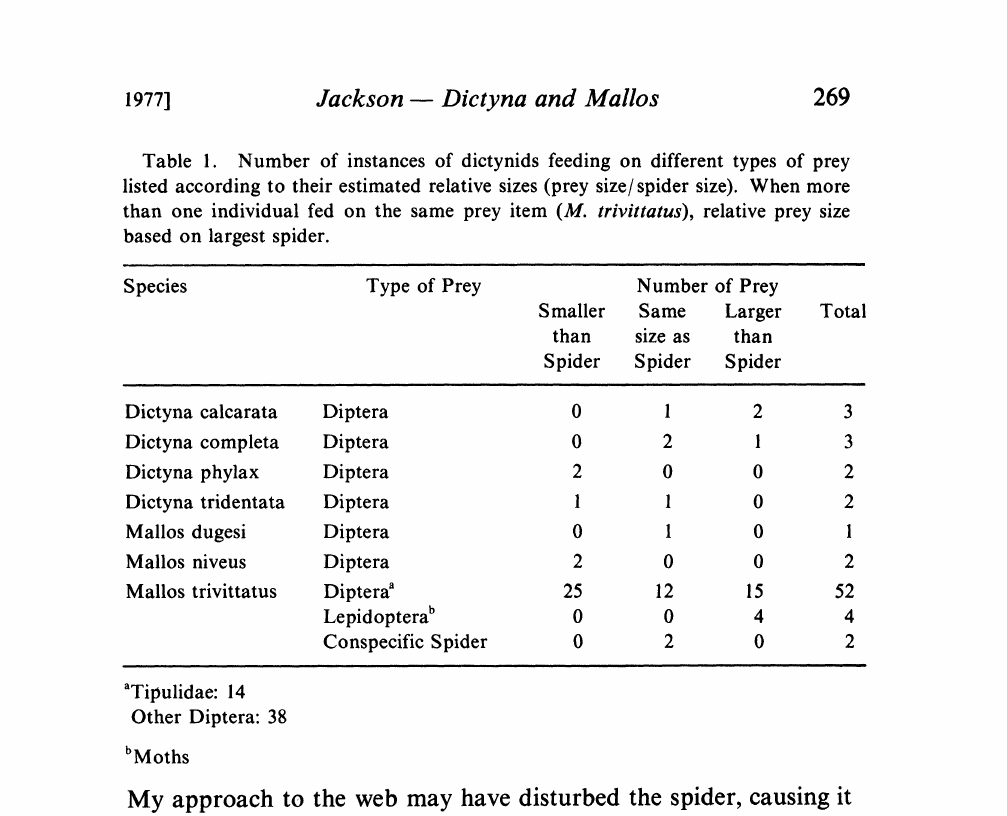
Table 1. Number of instances of dictynids feeding on different types of prey listed according to their estimated relative sizes (prey size/spider size). When more than one individual fed on the same prey item (M. trivittatus), relative prey size based on largest